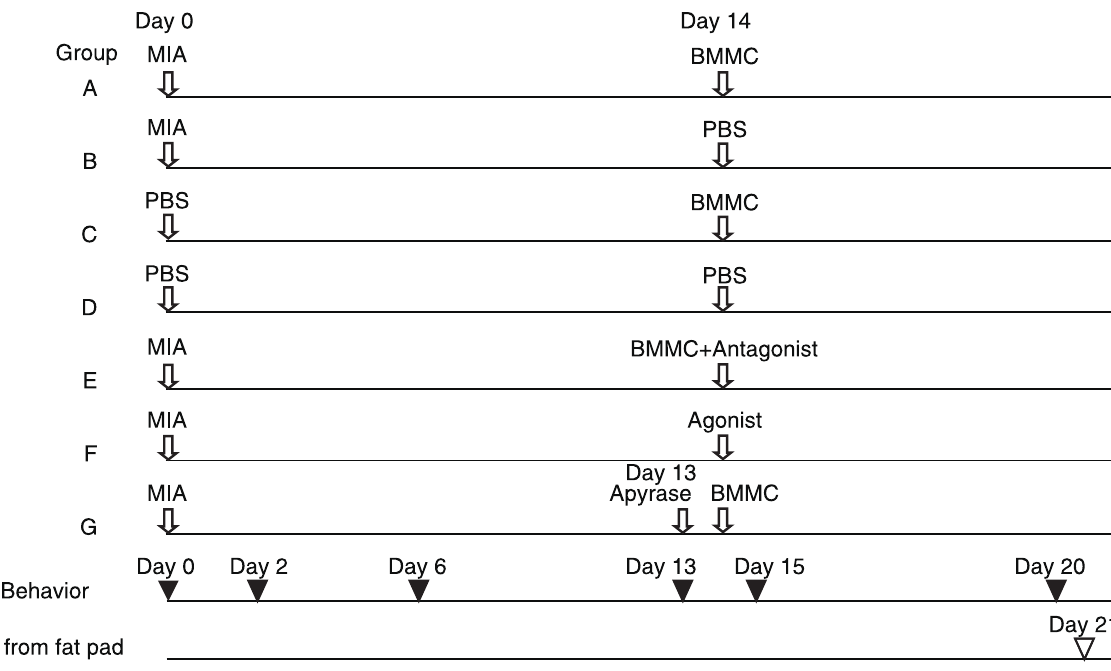
Fig 1. Design of experiments. Group A: MIA was injected on day 0 and BMMCs were injected on day 14; group B: MIA was injected on day 0 and PBS was injected on day 14; group C: PBS was injected on day 0 and BMMCs were injected on day 14; group D: PBS was injected on day 0 and PBS was injected on day 14; group E: MIA was injected on day 0 and a mixture of BMMCs and PAR2 antagonist was injected on day 14; group F: MIA was injected on day 0 and PAR2 agonist was injected on day 14; and group G: MIA was injected on day 0, apyrase was injected on day 13 and BMMCs were injected on day 14. The days of injection of MIA, PBS, PAR2 antagonist, PAR2 agonist and apyrase were shown in open arrows. The amount and volume injected were described under Materials and methods. Pain-related behavior was observed on the days indicated by filled arrowheads. Total RNA was extracted from the infrapatellar fat pads on the day indicated by open arrowhead.